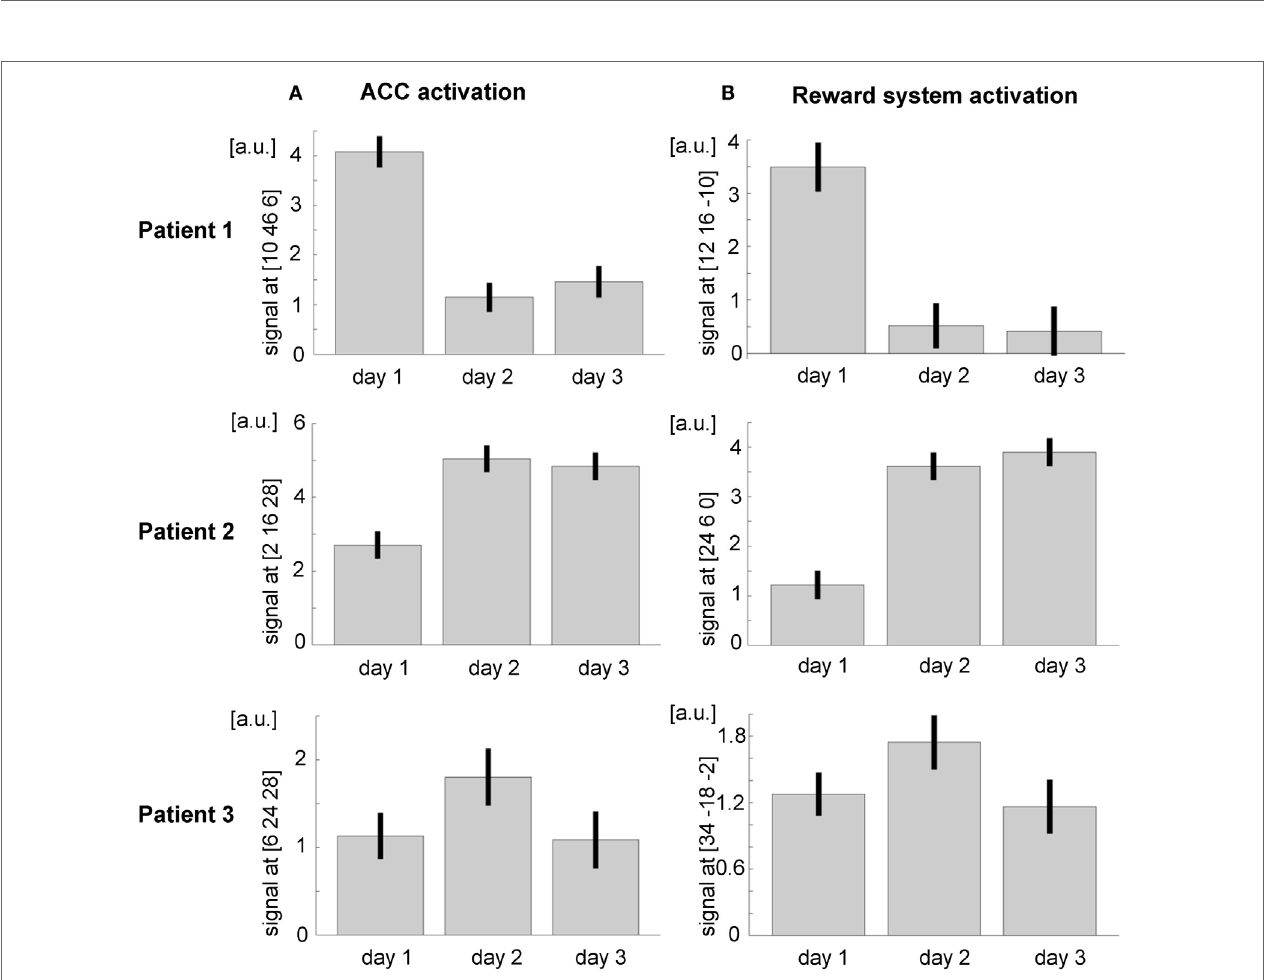
FIGURe 6 | Region of interest (RoI) analysis (a) in the aCC and (B) in the reward system revealed a general trend for increasing activity over the three training days . However, the interindividual differences are remarkable; a.u., arbitrary